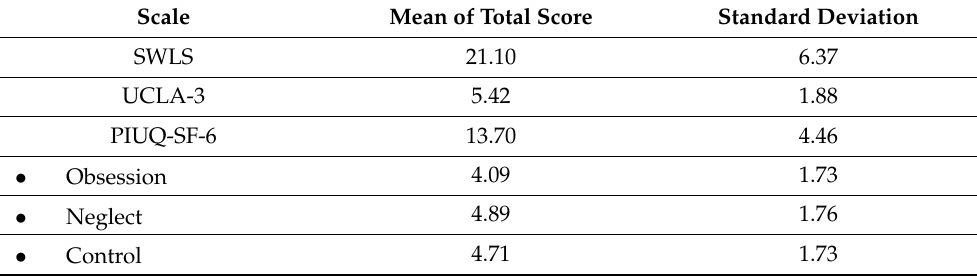
Table 3. Descriptive statistics for psychological measures.